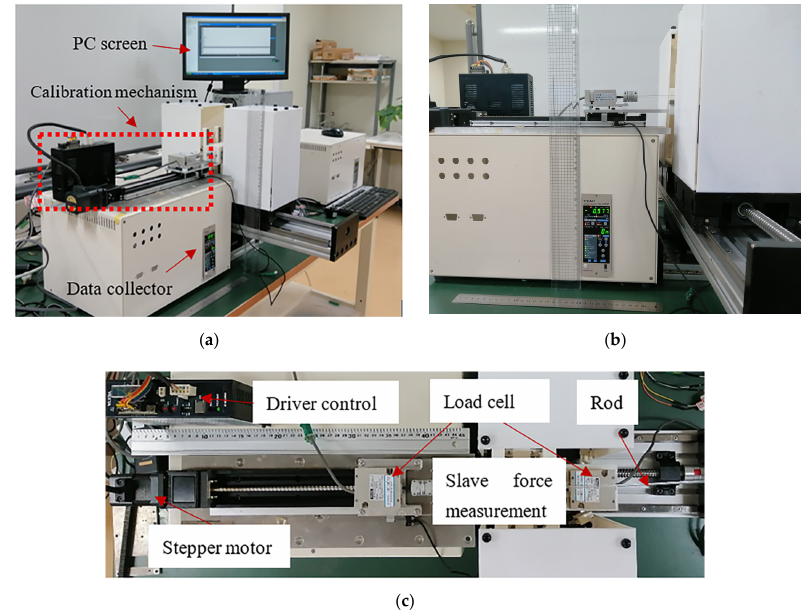
Figure 11. Schematic diagram of axial force calibration. ( a ) Full view; ( b ) front view; ( c ) top view.